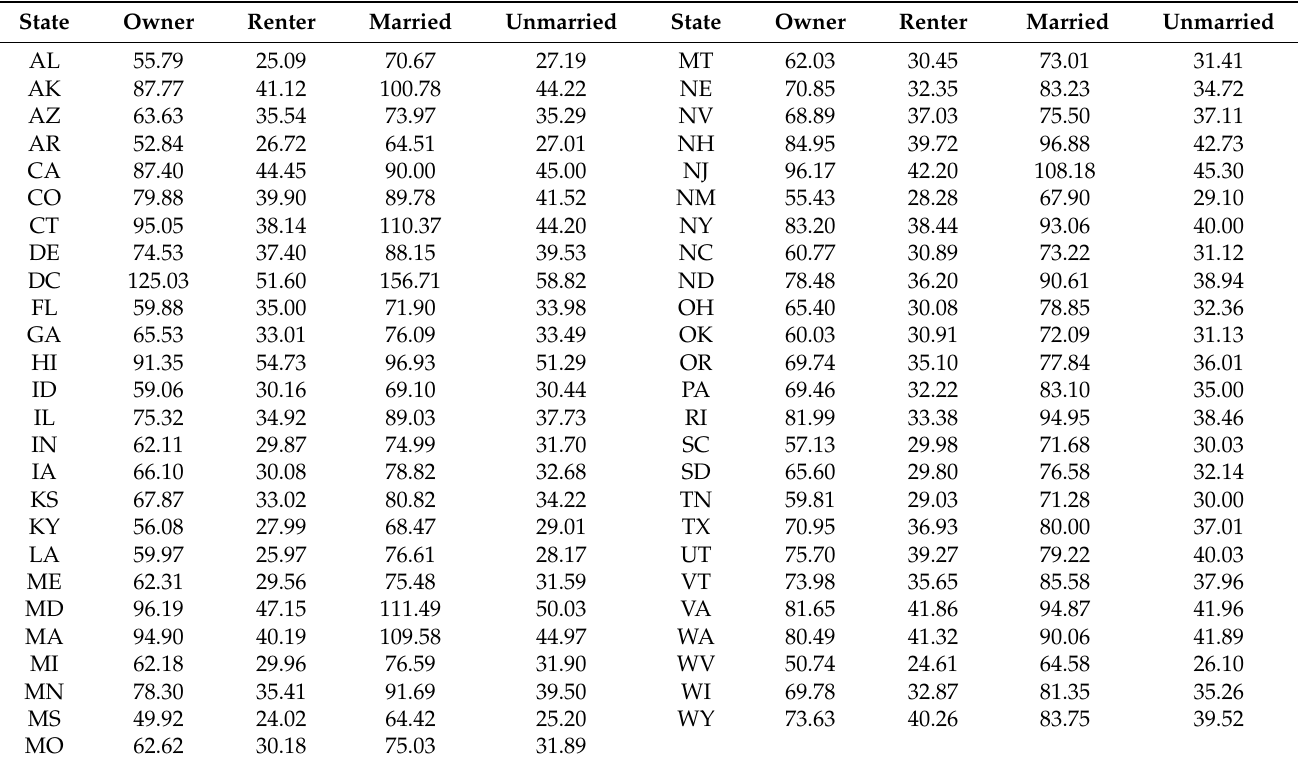
Figure 2. Estimated small area means from FH, LA, and HS models for four subgroups in all states. Table 3. Median income estimates from the HS